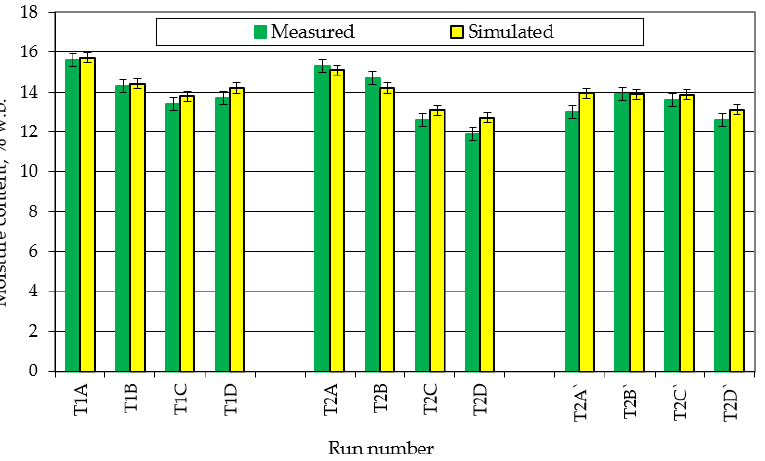
Figure 16. Results of experimental and modeling final tobacco moisture content.